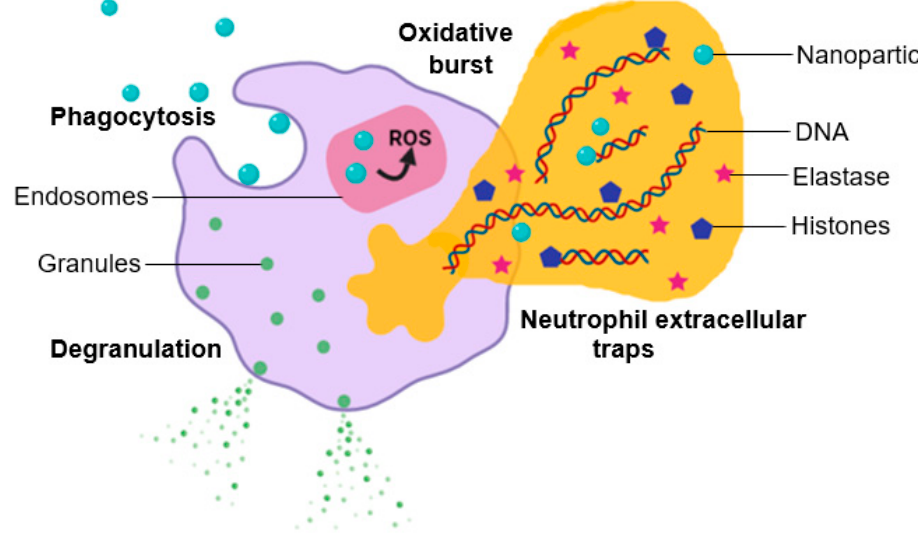
ff ect of nanoparticle–neutrophil Figure 6. Potential effect of nanoparticle–neutrophil interactions. Figure 6. Potential e